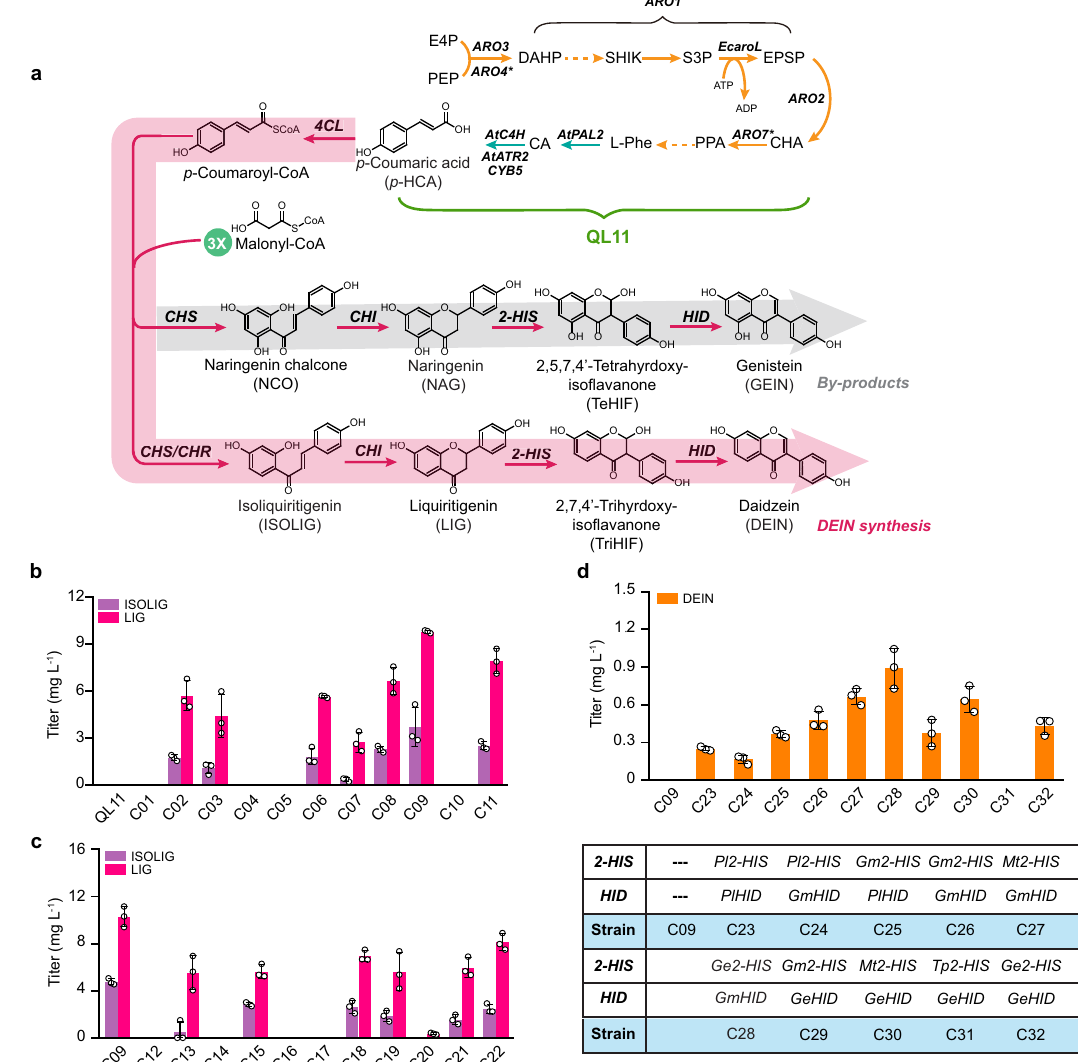
Fig. 2 Building and validating the biosynthetic pathway for DEIN. a Schematic illustration of the biosynthetic pathways leading to the production of DEIN and related byproducts. To ensure ef fi cient screening of biosynthetic enzymes for DEIN production, a p -HCA producing strain QL11, harboring overexpression of enzymes responsible for both endogenous (yellow arrows) and exogenous (blue arrows) reactions, was selected as the starting strain. ARO3 , DAHP synthase; ARO4 *, L-tyrosine-feedback-insensitive DAHP synthase ( ARO4 K229L ); ARO1 , pentafunctional aromatic protein; EcaroL , shikimate kinase from E. coli ; ARO2 , chorismate synthase; ARO7 *, L-tyrosine-feedback-insensitive chorismate mutase ( ARO7 G141S ); AtATR2 , cytochrome P450 reductase from A. thaliana ; CYB5, yeast native cytochrome b5. DAHP, 3-deoxy-D-arabino-2-heptulosonic acid 7-phosphate; SHIK, shikimate; S3P, shikimate-3-phosphate; EPSP, 5-enolpyruvyl-shikimate-3-phosphate; CHA, chorismic acid; PPA, prephenate. See Fig. 1 and its legend regarding abbreviations of metabolites and other gene details. b , c Production pro fi les of intermediates LIG and ISOLIG produced by yeast strains harboring different combinations of biosynthetic enzymes 4CL, CHS, CHR, and CHI. d DEIN production of C09 strain overexpressing different biosynthetic genes encoding 2-HIS and HID and relevant genetic characteristics of the resultant strains. For the source of selected plant genes: Mt , Medicago truncatula ; Tp , Trifolium pretense . See Fig. 1 legend regarding abbreviations of other plant species. Cells were grown in a de fi ned minimal medium with 30 g L − 1 glucose as the sole carbon source, and cultures were sampled after 72 h of growth for metabolite detection. All data represent the mean of n = 3 biologically independent samples and error bars show standard deviation. The source data underlying fi gures ( b − d ) are provided in a Source Data fi le.